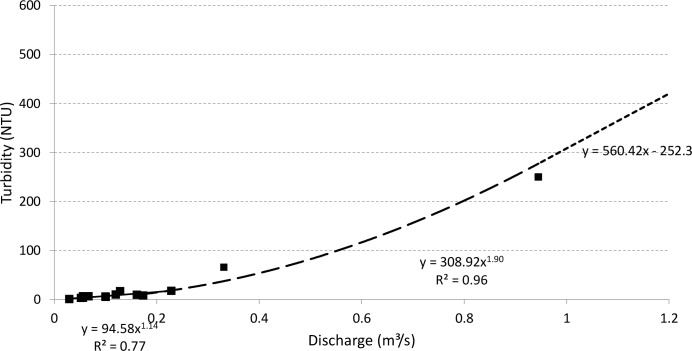
Turbidity as function of discharge for 18 samples in the mouth of Posses watershed.